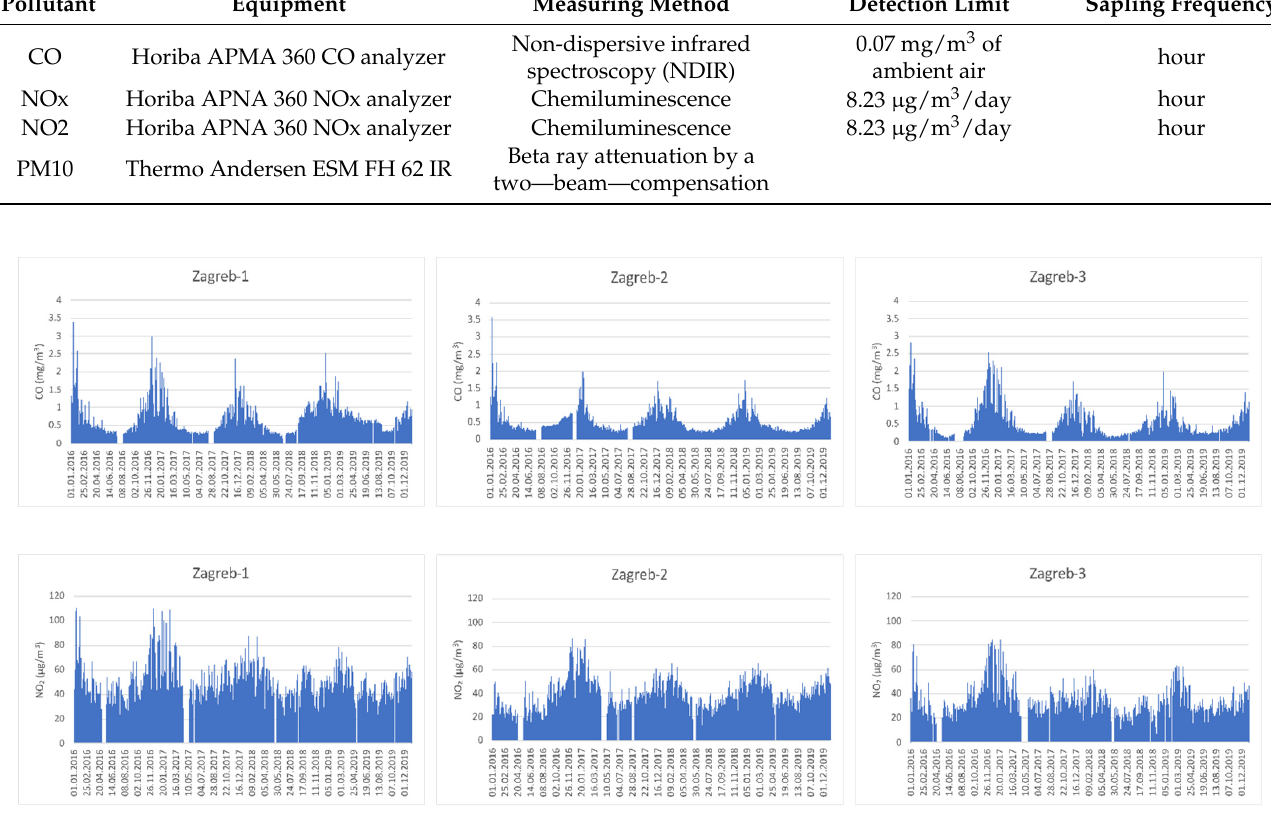
Figure 4. Air pollution in three different locations in Zagreb . 4. Results and Discussion Clean air is an essential and constant need for human health, as well as for all forms of life on Earth. Numerous studies show that air pollution affects different aspects of health at even lower concentrations than previously known. On 26 May 2015 in Geneva, Switzerland, the 68th World Health Assembly adopted a landmark resolution, “Health and the environment: addressing the health impact of air pollution”, identifying air pol- lution as a risk factor for nontransmissible diseases, such as asthma, ischaemic heart dis- ease, stroke, chronic obstructive pulmonary disease, and cancer [51]. The WHO issued guidelines in 2021 as a means to offer quantitative health-based recommendations for air quality. These guidelines provide values for long- and short- term concentrations of a number of key air pollutants whose exceedance can pose a risk to public health (Table 2) [52].